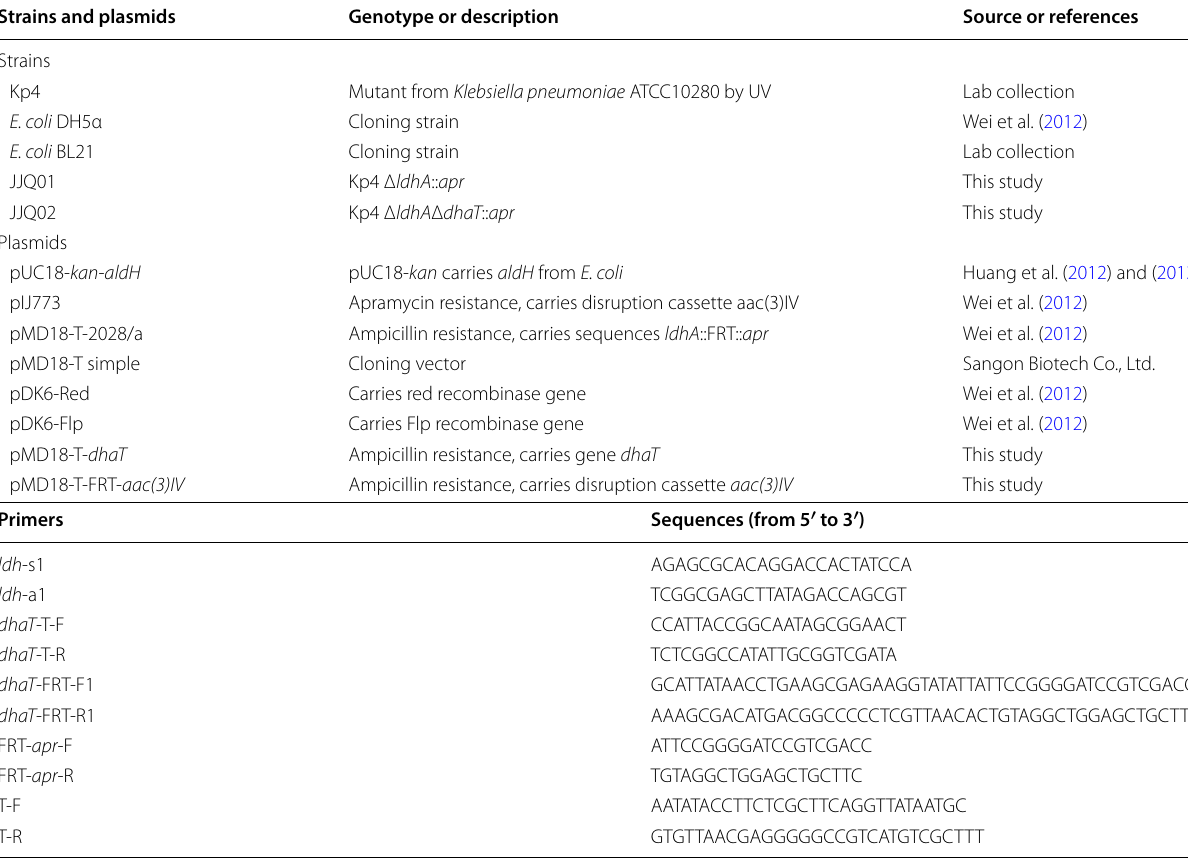
Table 1 Strains and plasmids used in this study Strains and